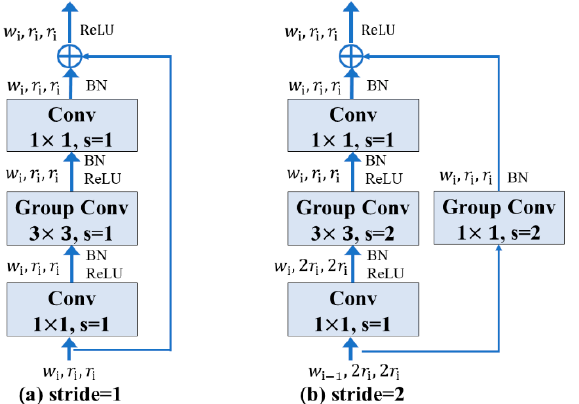
Figure 8. The structure of residual bottleneck block. ( a ) Case of stride = 1, ( b ) Case of stride = 2.